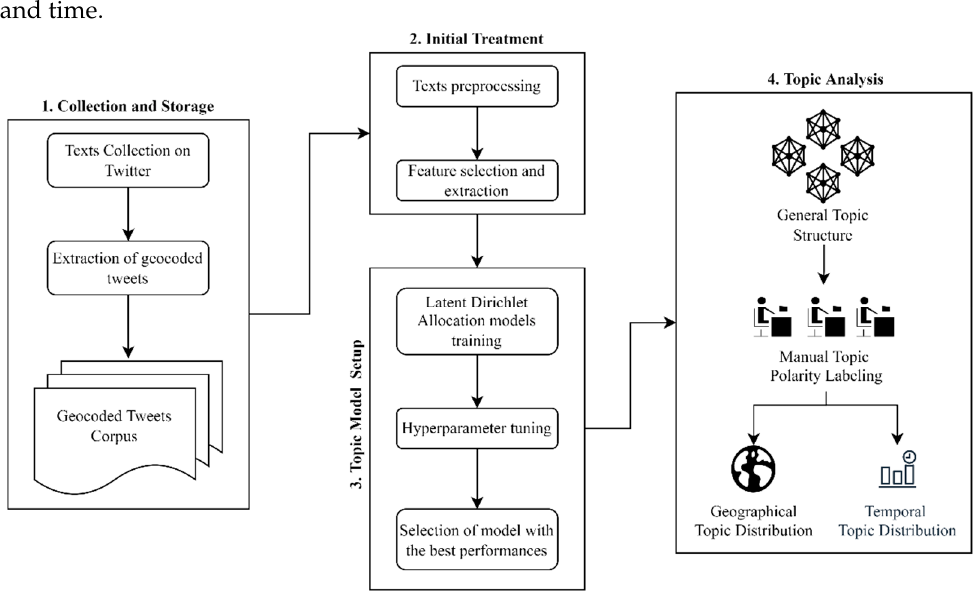
Figure 1. Workflow for the spatio-temporal topic analysis.